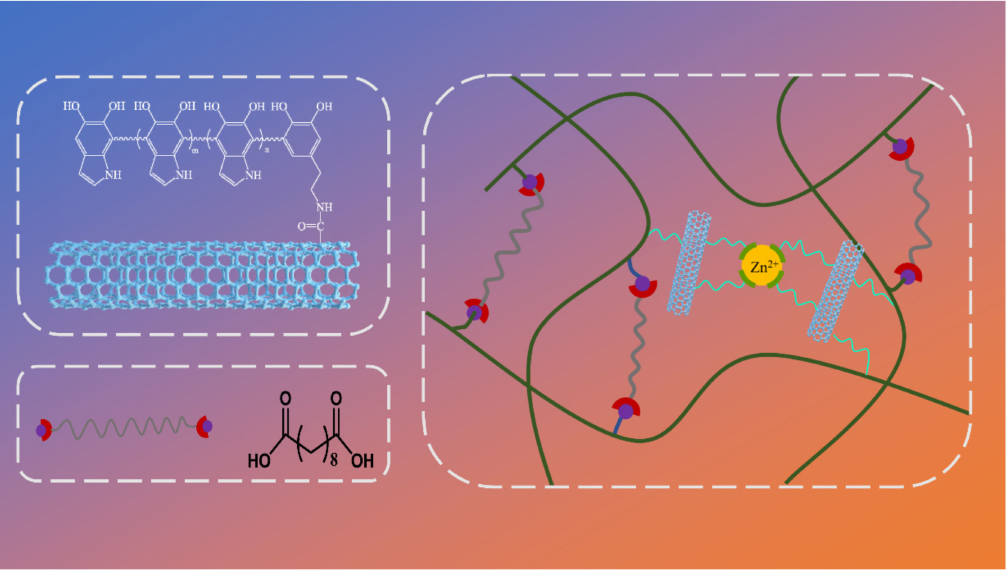
Figure 1. Chemical structures of MWCNTs@PDA and network of epoxy composites crosslinked by dynamic transesterification and metal–catechol